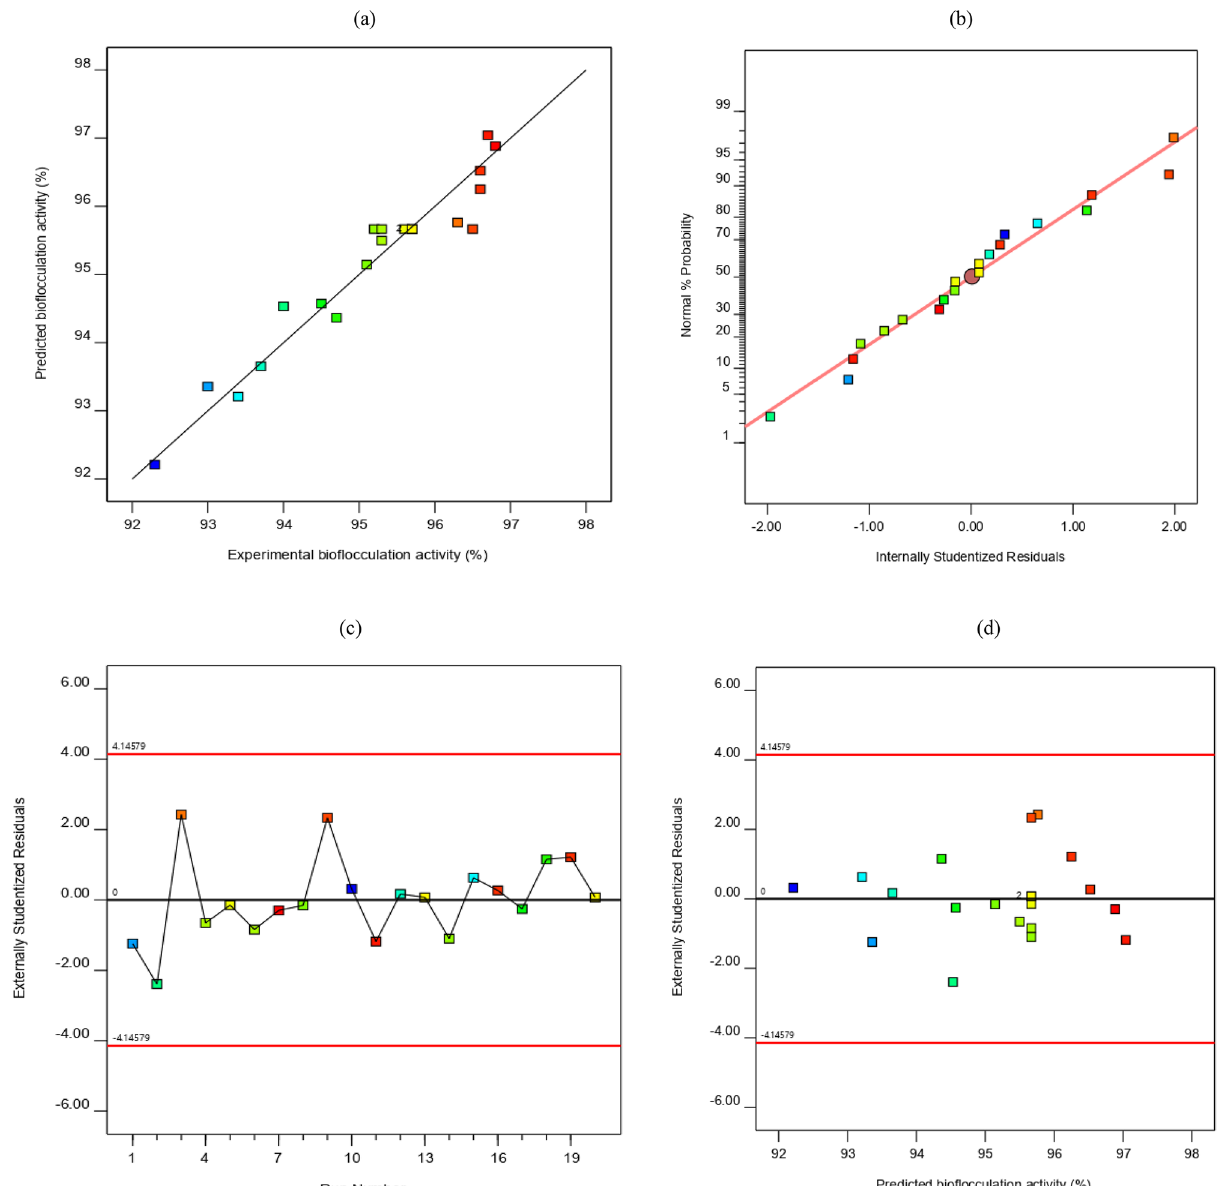
Figure 1. Model adequacy plots of bioflocculation activity ( a ) predicted response vs experimental response; ( b ) normal plot of residuals; ( c ) residuals vs predicted, and ( d ) outlier t